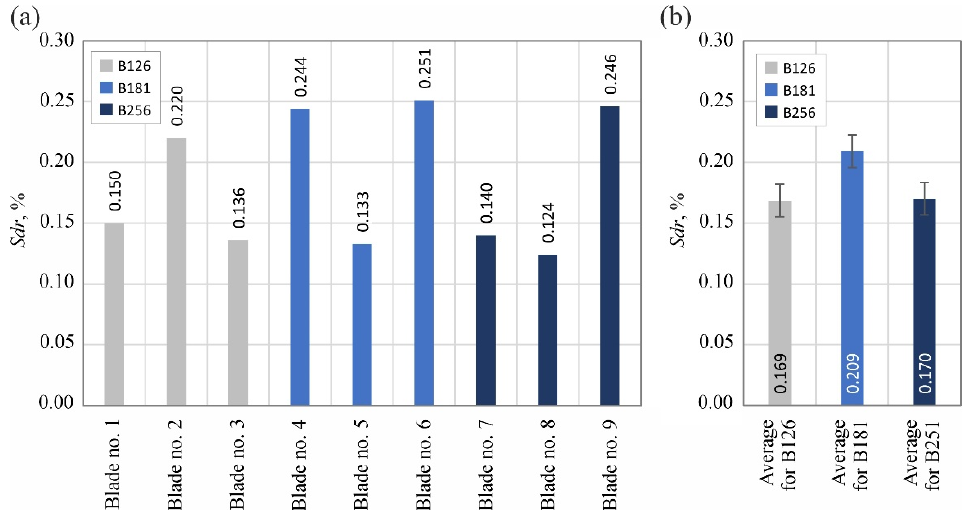
Figure 16. Changes in the root-mean-square slope of the surface Sdq : ( a ) results for nine blades se- lected for surface texture measurements; ( b ) average values determined by the size of the cBN abra- sive grain of the grinding wheel used (error bars represent the standard error equal to the standard deviation σ divided by the square root of the total number of samples).